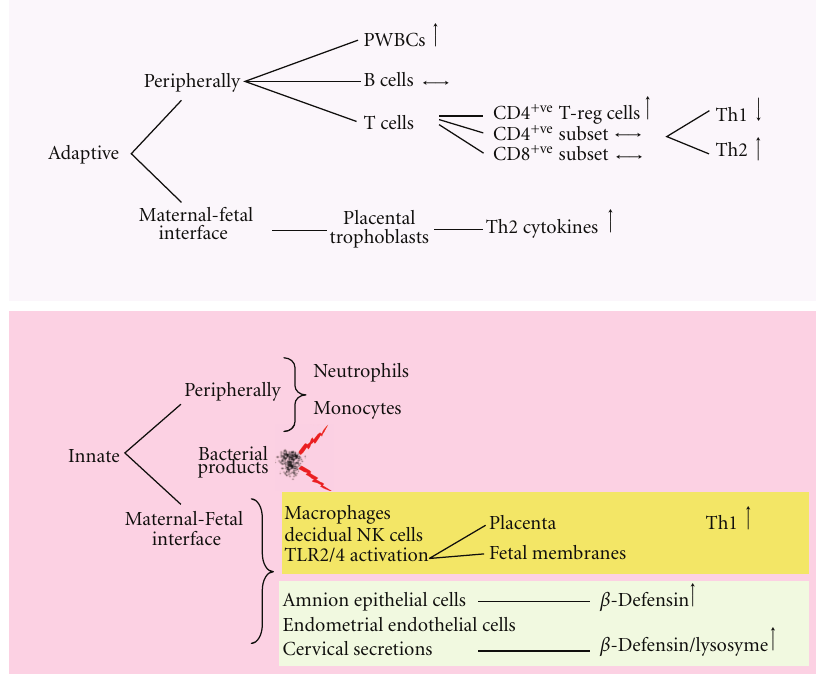
Figure 1: Summary of the adaptive and innate immune system in pregnancy. Mediators of the adaptive and innate immune system work in parallel to facilitate a balance between immune tolerance of the fetus whilst maintaining the ability to mount a response against invading pathogens. PWBC: peripheral white blood